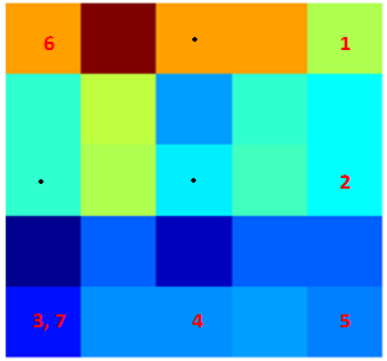
Figure 8. Alternatives for insulation of walls on the self-organizing map (SOM).